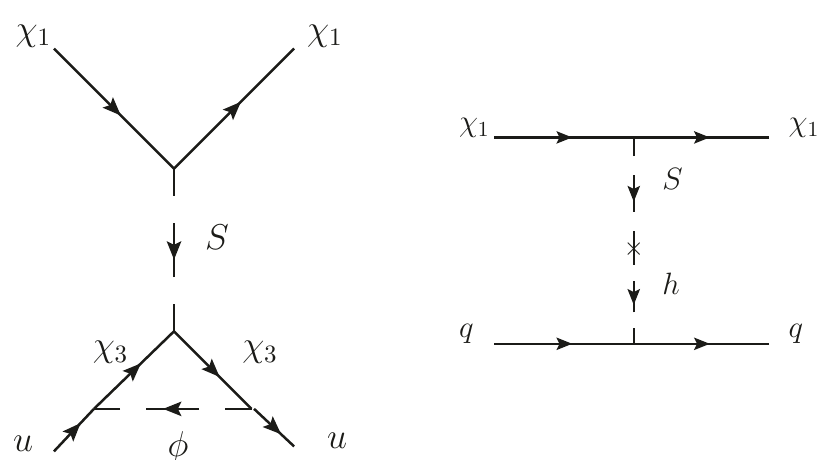
Figure 10 . Diagrams contributing to DM-nucleus scattering χ 1 N → χ 1 N . The diagram on the left is the dominant contribution in the minimal model while the diagram on the right may dominate if the S -Higgs mixing is present.